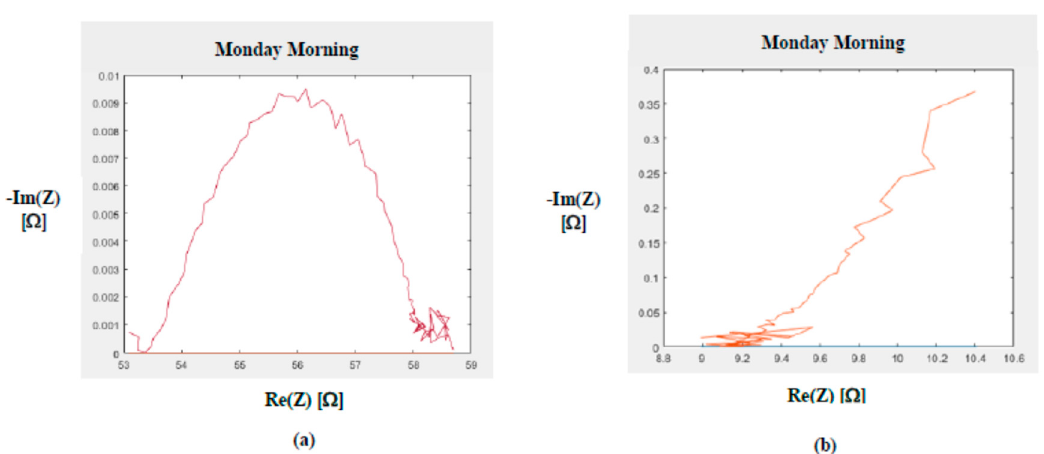
Figure 7. ( a ) Cole–Cole diagram for S3, at MM test point. ( b ) Cole–Cole diagram for S5, at MM test point.